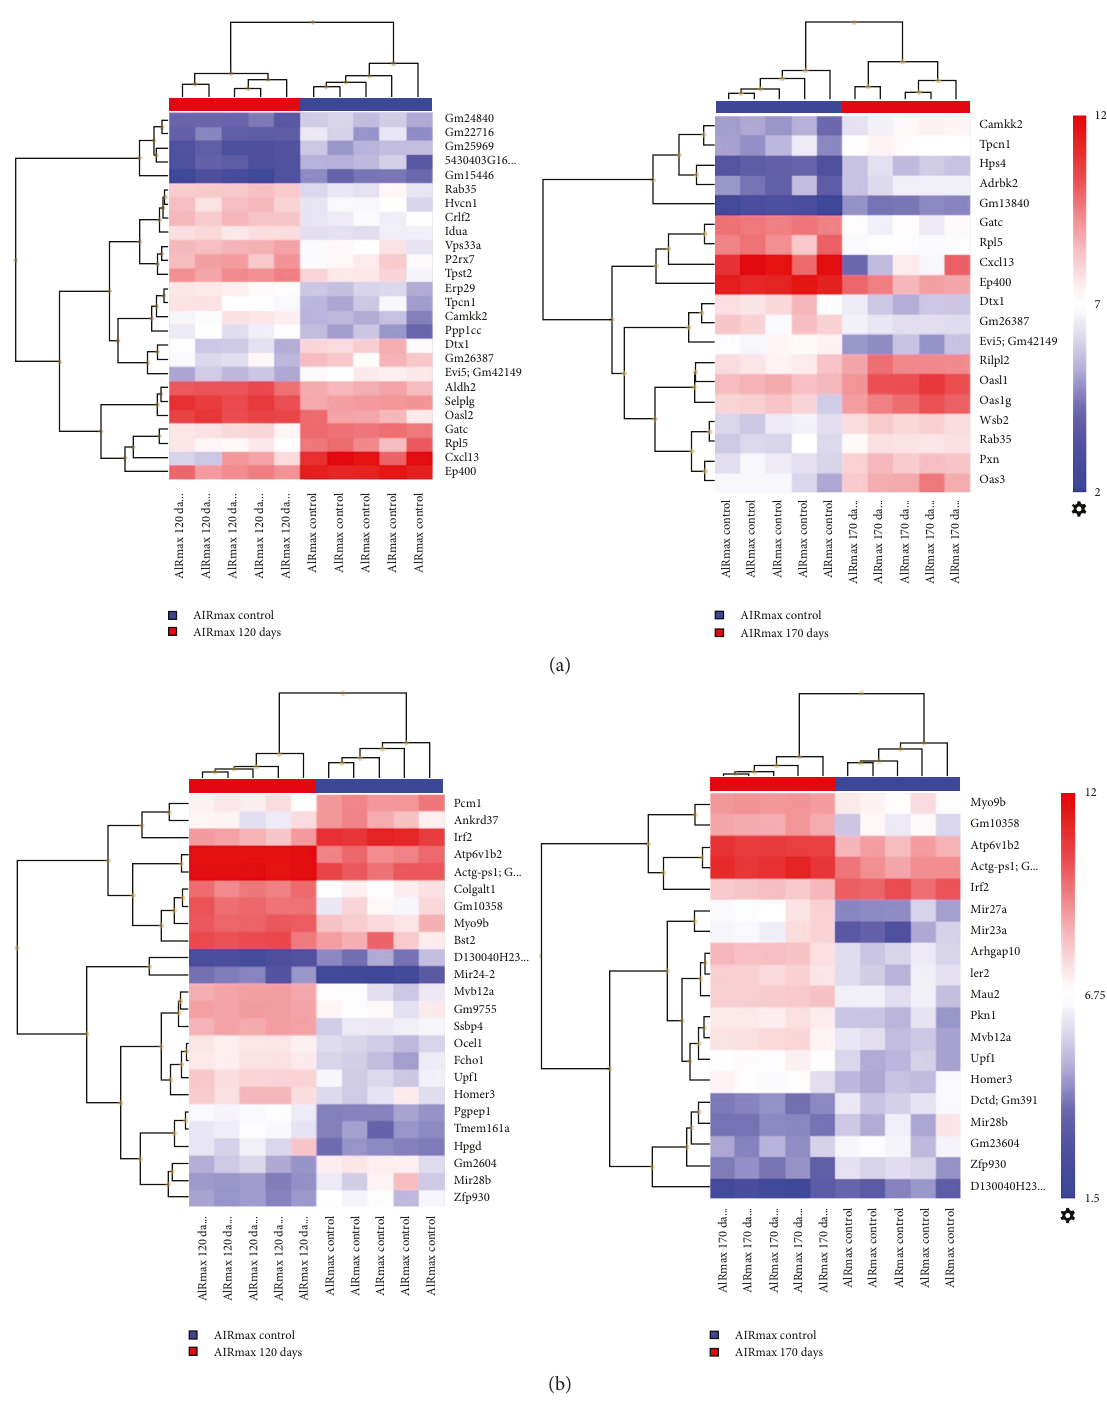
Figure 2: Up- and downregulated genes in AIRmax lines, located in the 1-LOD score con fi dence interval (CI) of Prtia2 (Chr 5) and Prtia3 QTL (chr 8) ( > 3-fold). (a) Chromosome 5: left — 120 days; right — 170 days. (b) Chromosome 8: left — 120 days; right — 170 days. Di ff erentially expressed genes (DEGs) were detected using unpaired one-way ANOVA, with FDR < 0 05